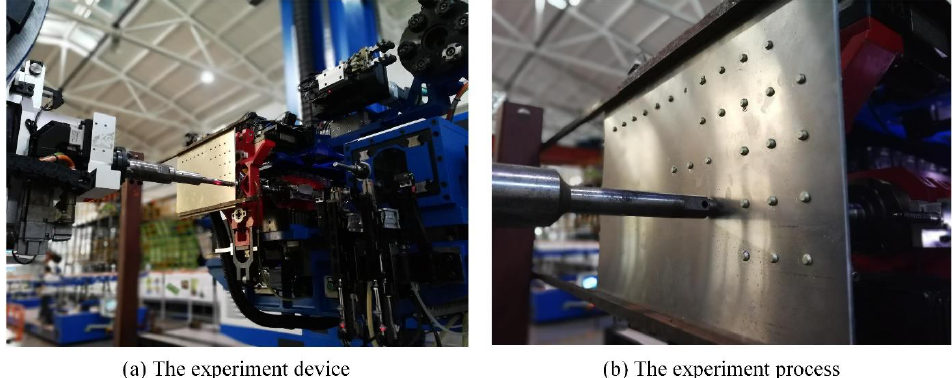
Figure 16. The experiment process using different protruding heights. ( a ) The experiment device; ( b ) The experiment process.